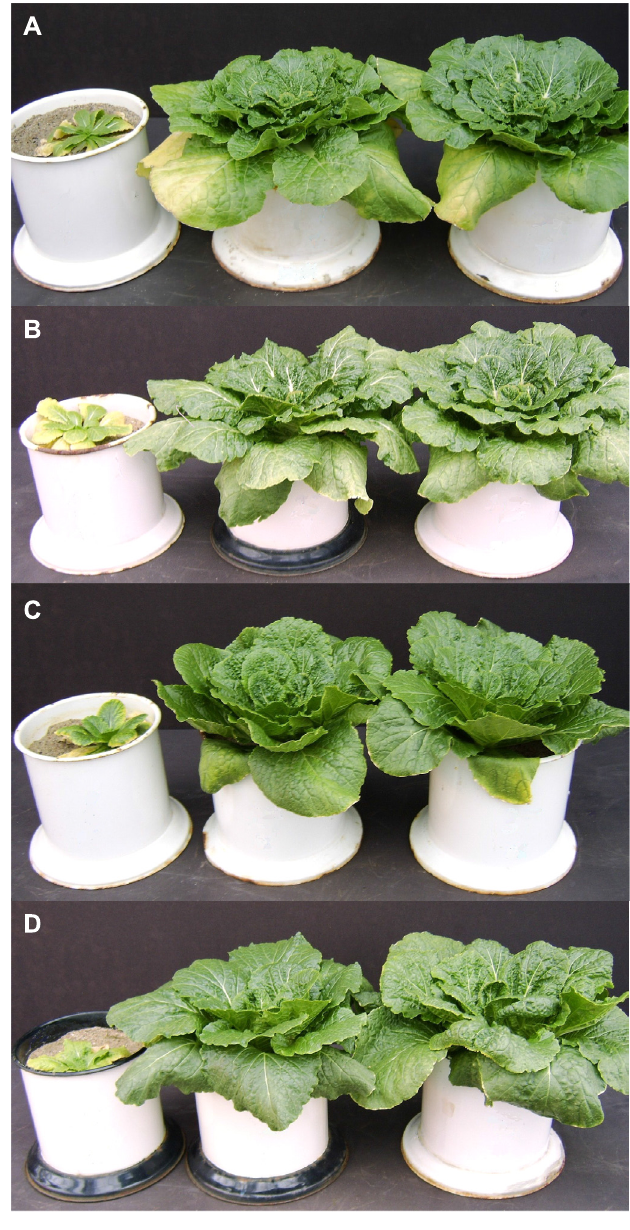
Fig. 1: Chinese cabbage cvs. Yuki and Orient Surprise in dependency to N (1.0 and 2.0 g pot -1 ) and S (0, 0.3 and 0.6 g pot -1 ) supply. In each sub-figure, increasing S supply is ranked in ascending order from 0.0 over 0.3 to 0.6 g S pot -1 from left to right. A, Yuki at 1 g nitro- gen; B, Yuki at 2 g nitrogen; C, Orient Surprise at 1 g nitrogen; D, Orient Surprise at 2 g